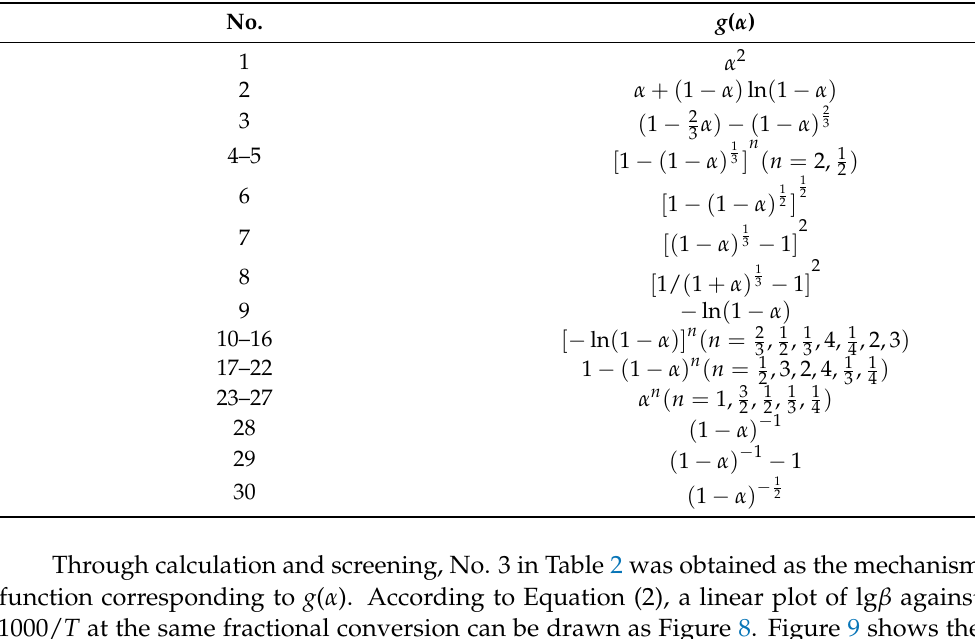
Figure 9. The E O curves of pyrolysis vs. degree of reaction created by the Ozawa method. According to the g ( α ) obtained by computational screening, the apparent activation energy and pre-exponential factor at the peak temperature were calculated using the Ozawa method and the Satava–Sestak method, respectively, as shown in Table 3. The ap- parent activation energy and the pre-exponential factor at the peak temperature calcu- lated by the three methods were relatively close, and the calculated results were accurate. Table 3. E a and lg A calculated by the three methods. Methods